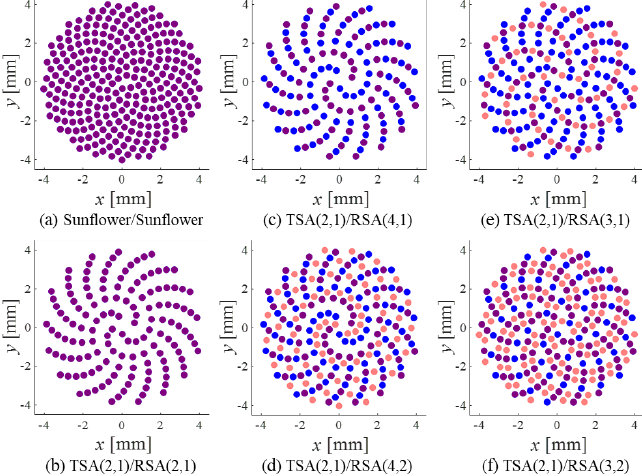
Figure 11. Transmit (blue) and receive (red) spiral array pairs: ( a ) the sunflower array pair and ( b – f ) the sparse spiral array (SSA) pairs. The overlapping elements are colored in purple.